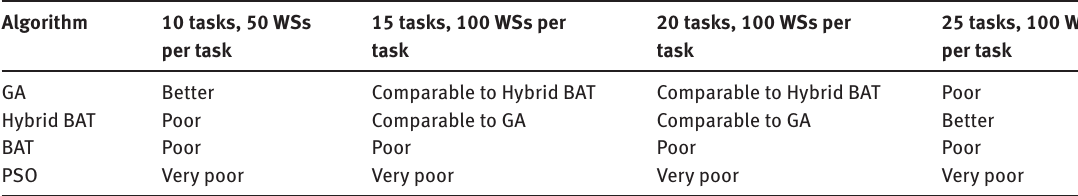
Table 4: Performance Comparison.